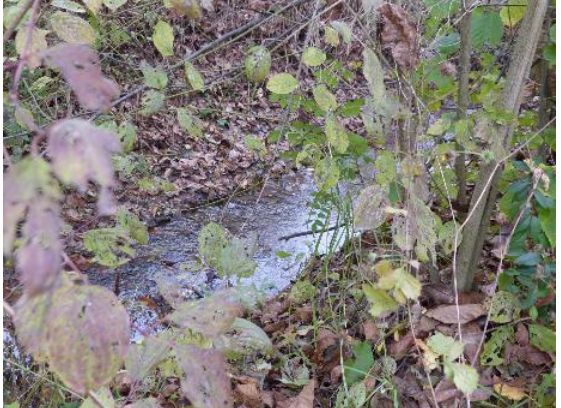
Figure 5. Lopašov flow—natural flow (Moyzeová, 2020).